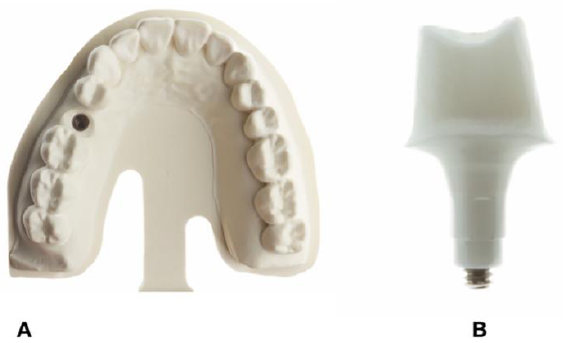
Figure 1. ( A ), Maxillary model with implant placed in right maxillary second bicuspid. ( B ), Milled Zirconia abutment.